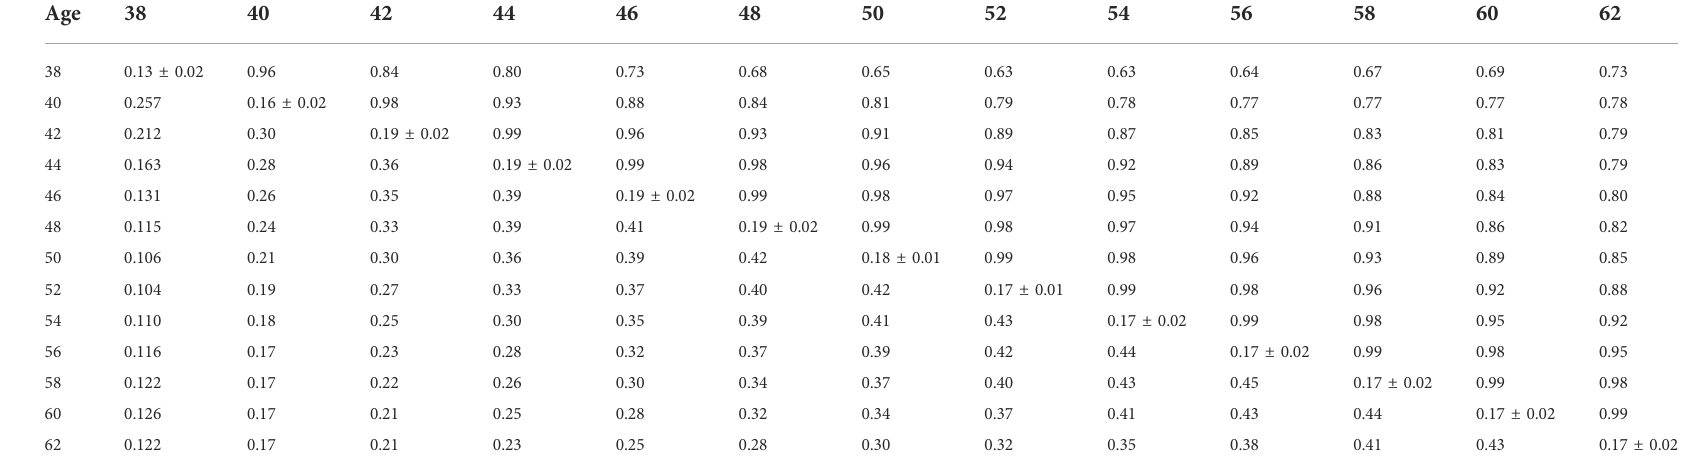
TABLE 8 Estimates of heritability (diagonal), phenotypic correlations (below diagonal), and genetic correlations (above diagonal) for hatch of fertile (HOF) using the ssGBLUP random regression model.